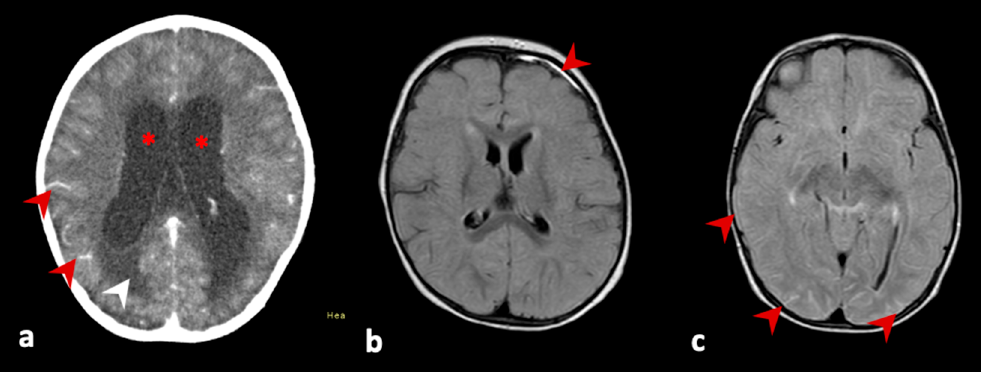
Figure 1. ( a ) Brain nuclear magnetic resonance (NMR) imaging of patient one. Dilatation of the ventricular system (asterisks) with signs of ependymal transudation (white arrowhead), and abnormal diffuse leptomeningeal enhancement (red arrow heads) in the image acquired with pre-contrast T1-weighted images. ( b ) Patient two’s radiologic findings. Focal pachymeningeal enhancement in the left frontal region (arrow) in the image acquired using fluid-attenuated inversion-recovery (FLAIR). ( c ) Patient three’s radiologic findings. Arrows indicate the presence of diffuse leptomeningeal enhancement in the image acquired using fluid-attenuated inversion-recovery (FLAIR).